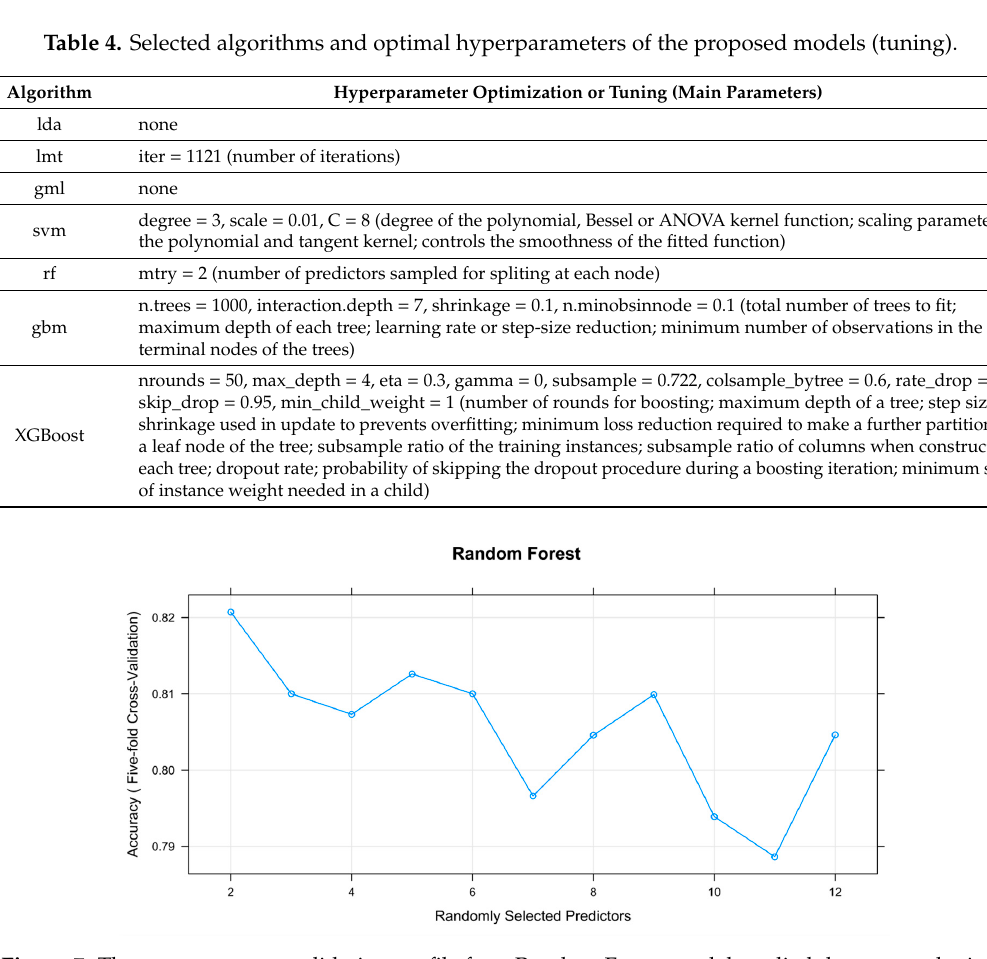
Table 4. Selected algorithms and optimal hyperparameters of the proposed models (tuning). Algorithm Hyperparameter Optimization or Tuning (Main Parameters)